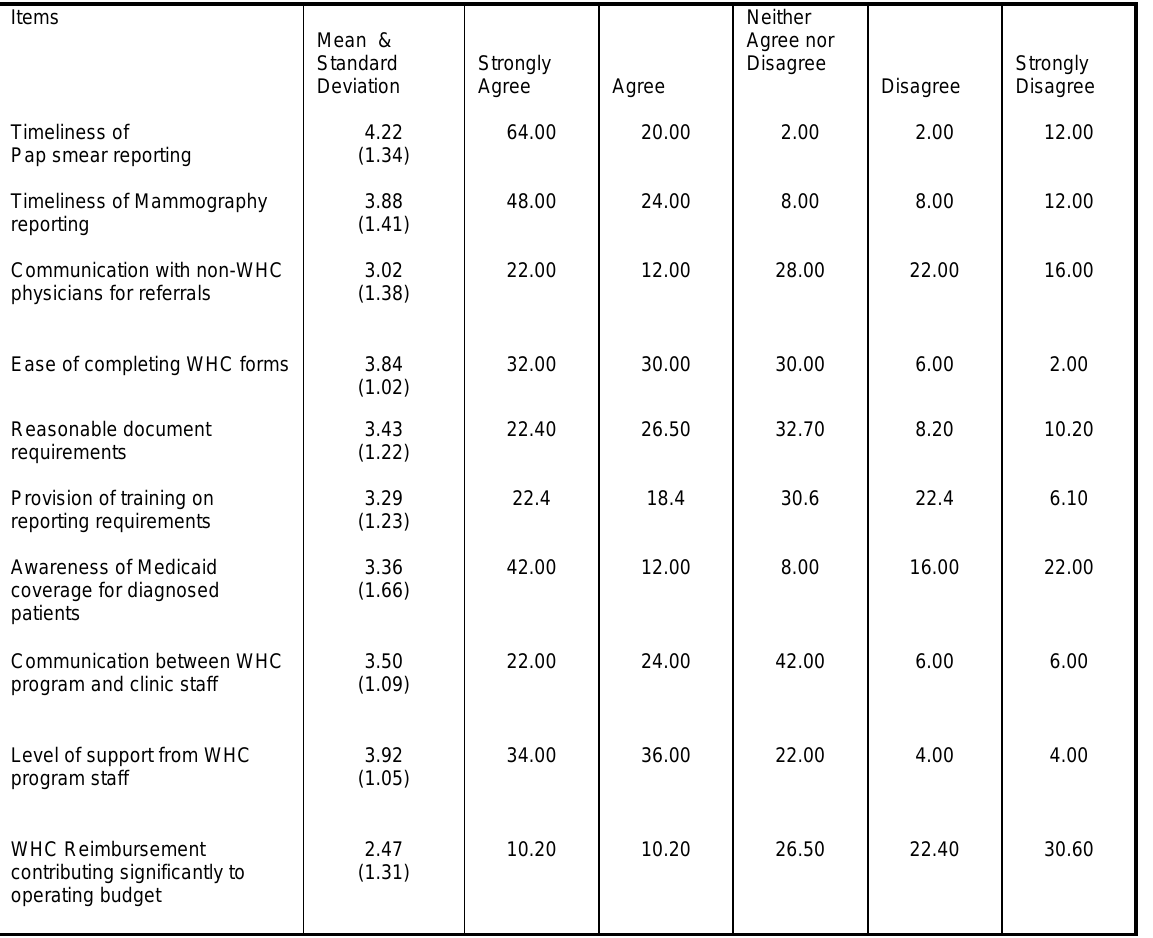
Means and Standard Deviation of Items for Physician Satisfaction in the Nevada WHC